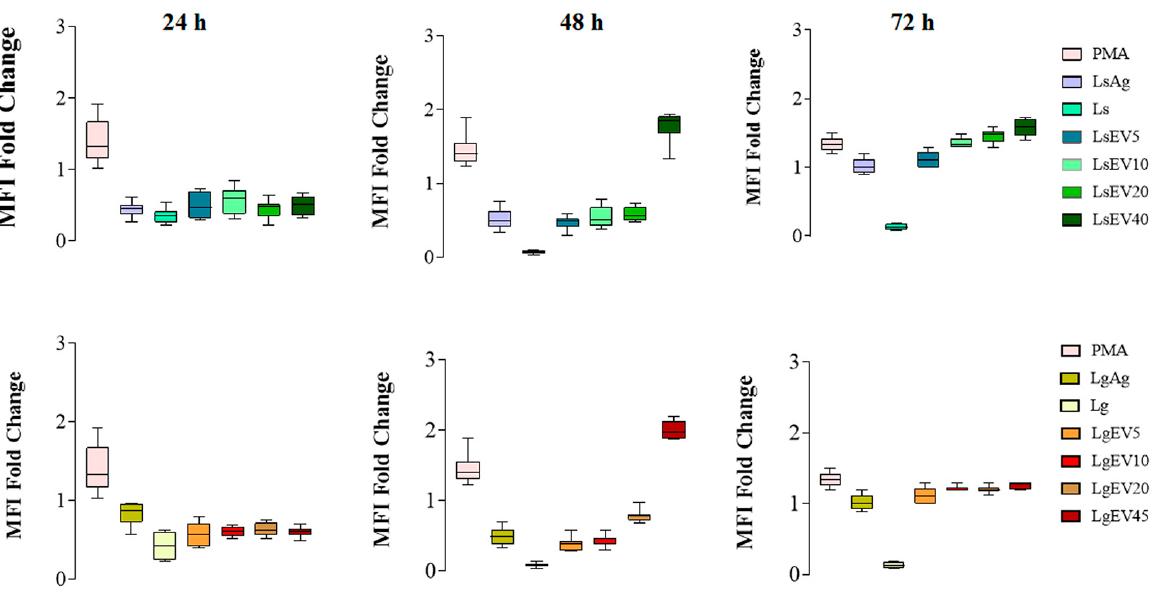
Figure 11. Effect of L. shawi and L. guyanensis EVs on density of MHCI and MHCII molecules. M Φ incubated for 24 h, 48 h, and 72 h with 5 (LsEV5; LgEV5), 10 (LsEV10; LgEV10), 20 (LsEV20; LgEV20), and 45 µ g · mL − 1 (LsEV45; LgEV45) of EVs shed by L. shawi and L. guyanensis , parasite antigens (Ag), and L. shawi (Ls) and L. guyanensis (Lg) promastigotes were analyzed by multiparametric flow cytometry. Fold changes in MHC molecules are represented by the MFI (median fluorescence intensity). PMA—M Φ incubated with PMA as a positive